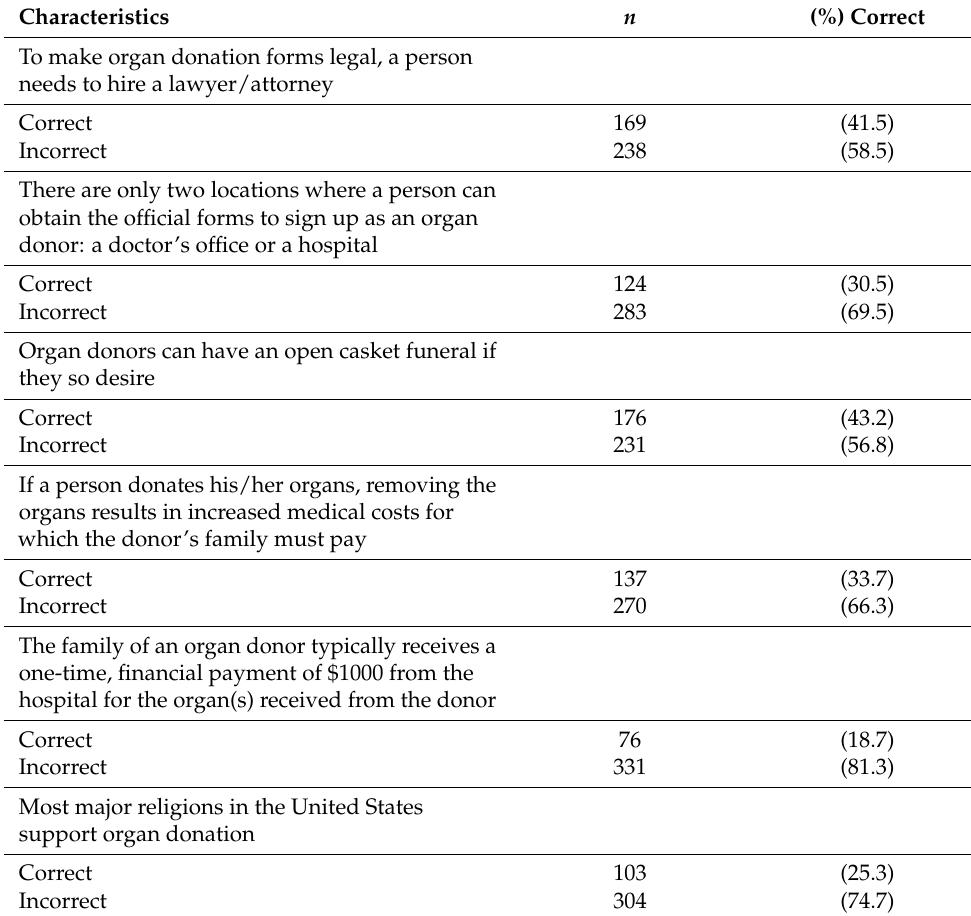
Table 3. Knowledge of Organ Donation Registration: True and False Questions.